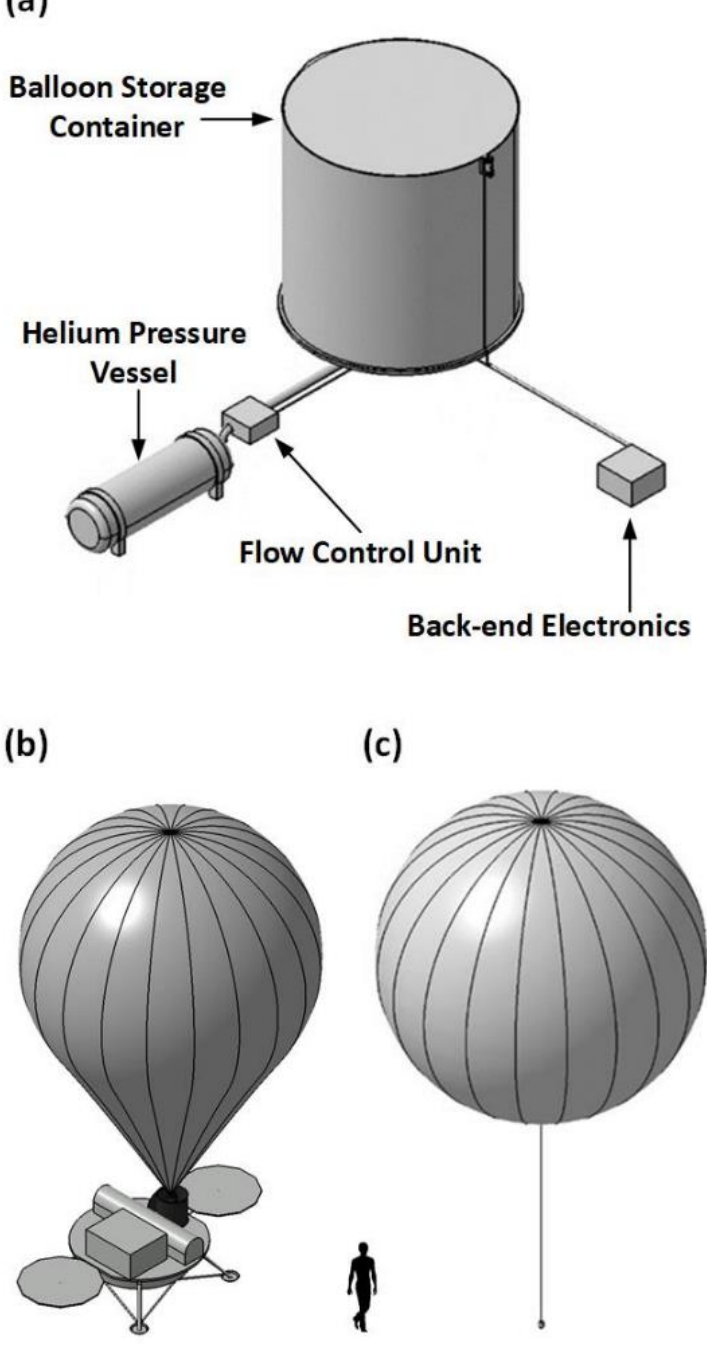
Figure 9. Configuration ( a ) with main components of instrument support system, ( b ) accommodation on a notional lander deck with balloon inflated to a ‘ready for launch’ state, and ( c ) fully inflated balloon probe.